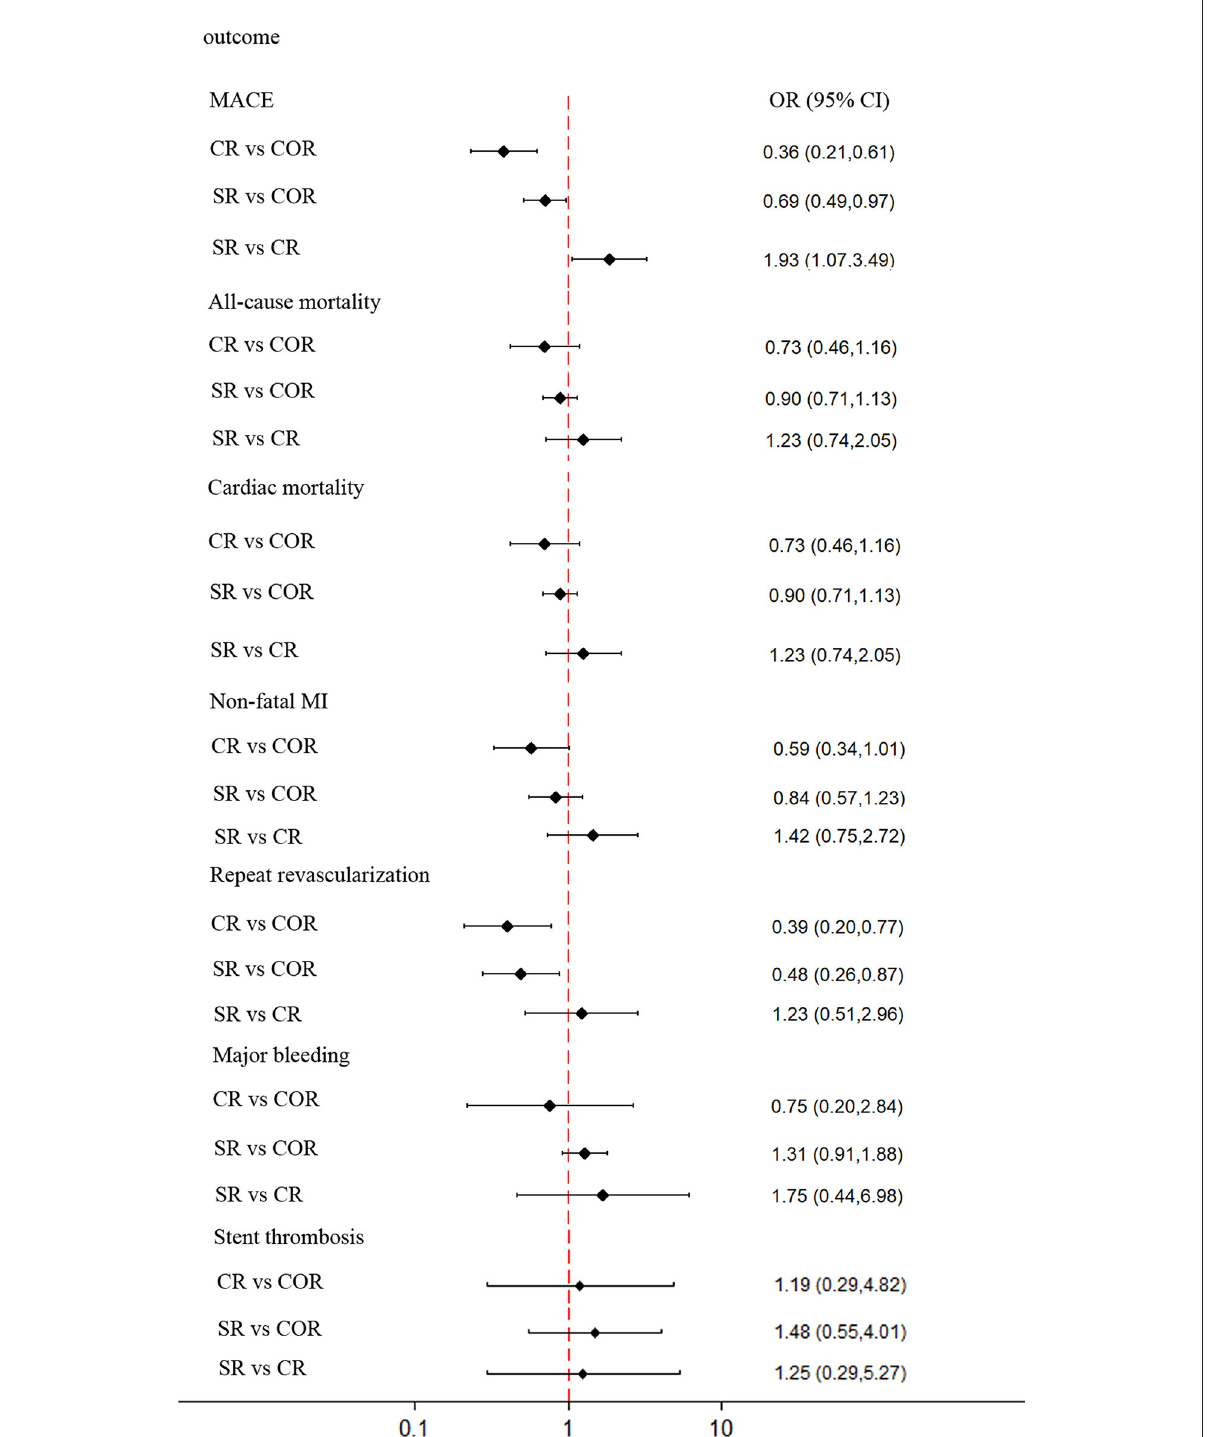
FIGURE5 Network meta-analysis outcomes. Forest plot for the network meta-analysis comparing the 3 different revascularization strategies for MACE, all-cause mortality, cardiovascular mortality, nonfatal myocardial infarction, repeat revascularization, major bleeding, and stent thrombosis. Diamonds represent OR values, and horizontal lines represent 95% confidence intervals. MACE, major adverse cardiac event (s); MI, myocardial infarction; OR, odds ratio; CR, complete revascularization at the time of primary PCI; SR, complete revascularization as a staged procedure; COR, culprit-only